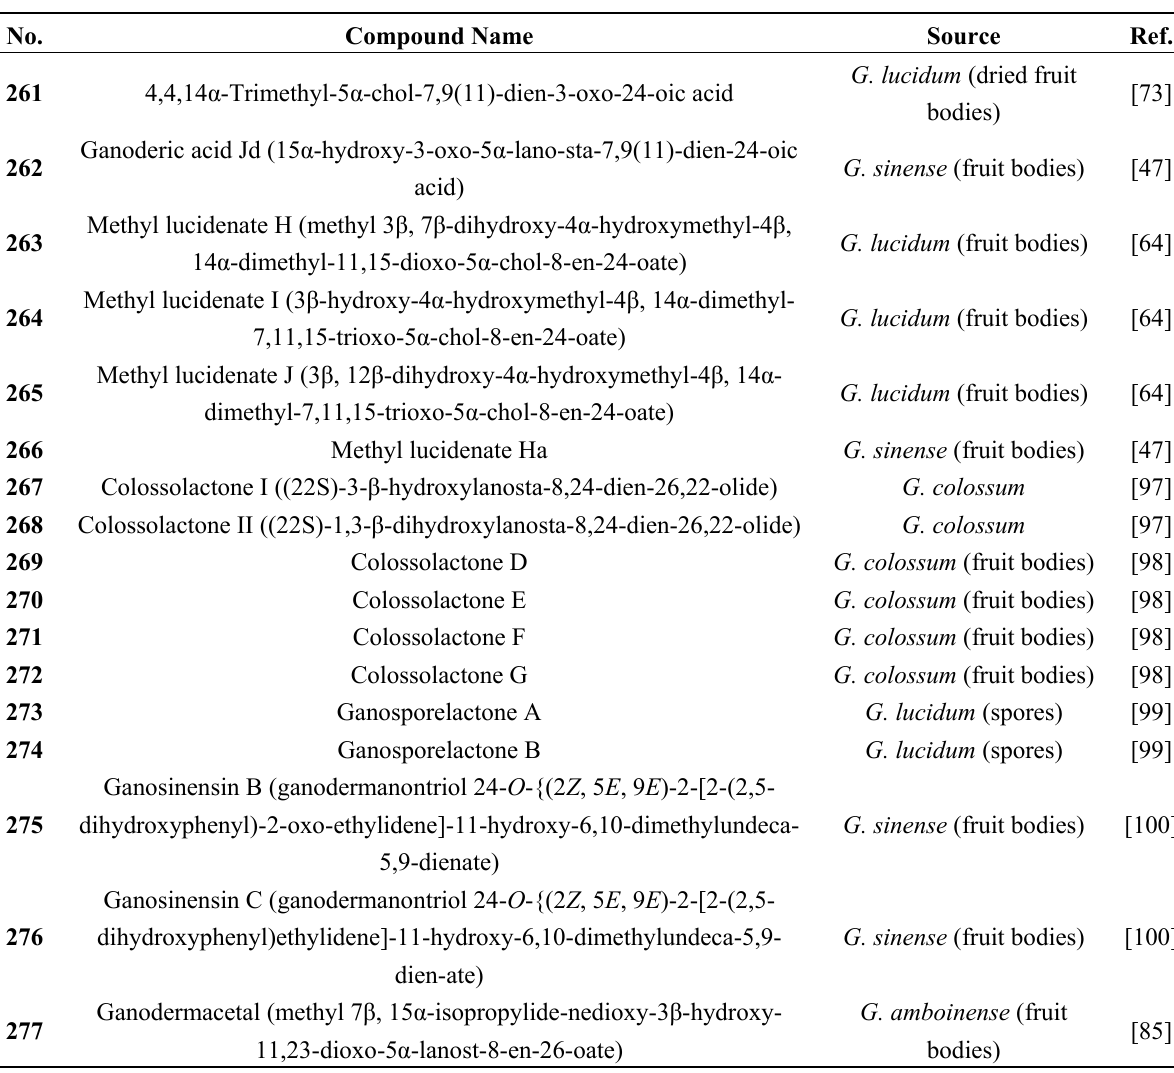
Table 10. Ganoderma triterpenes 261 – 280 in Figures